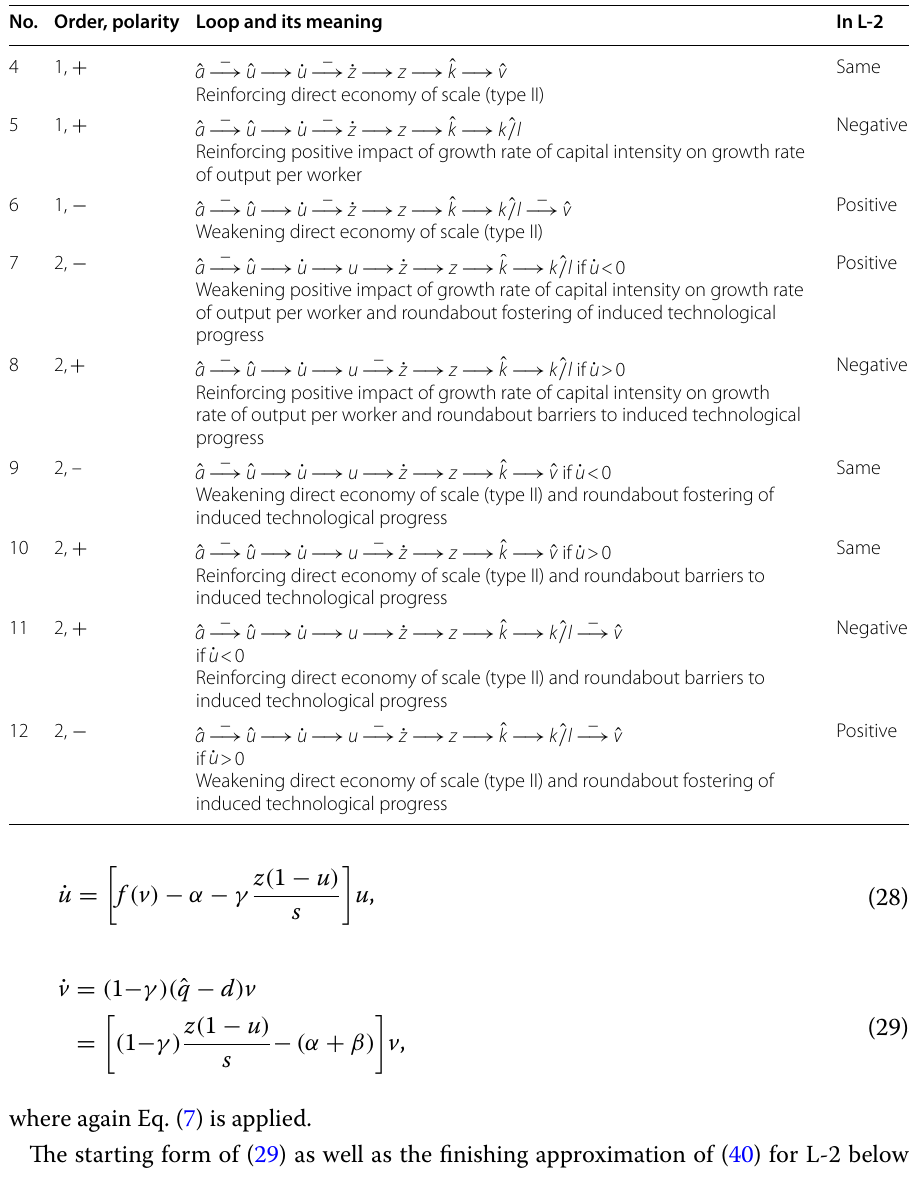
Table 7 Growth rate of output per worker in new extensive feedback loops within L-1 No. Order, polarity Loop and its meaning In